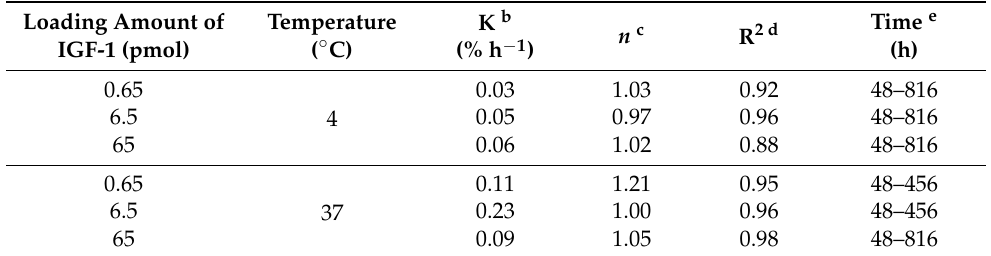
Table 1. Parameters obtained from Ritger and Peppas equation for IGF-1 release from SF films.